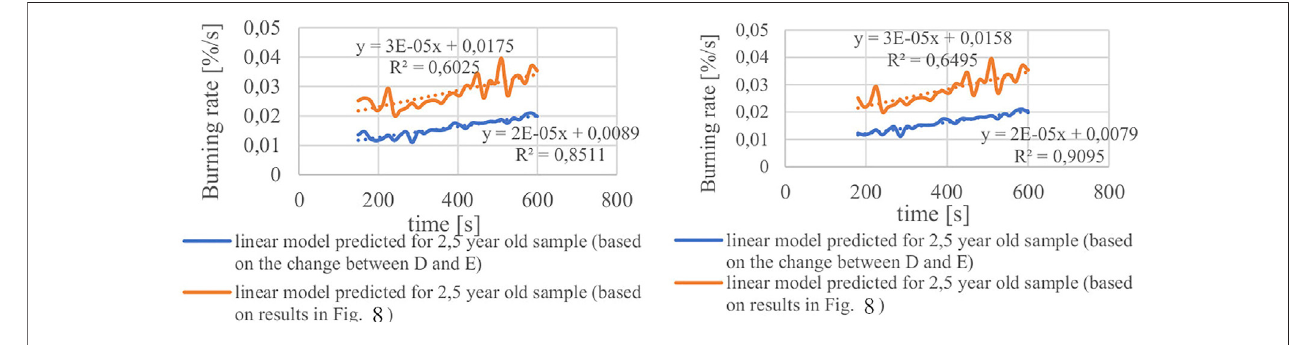
FIGURE 7 | Model for mass loss rate development.